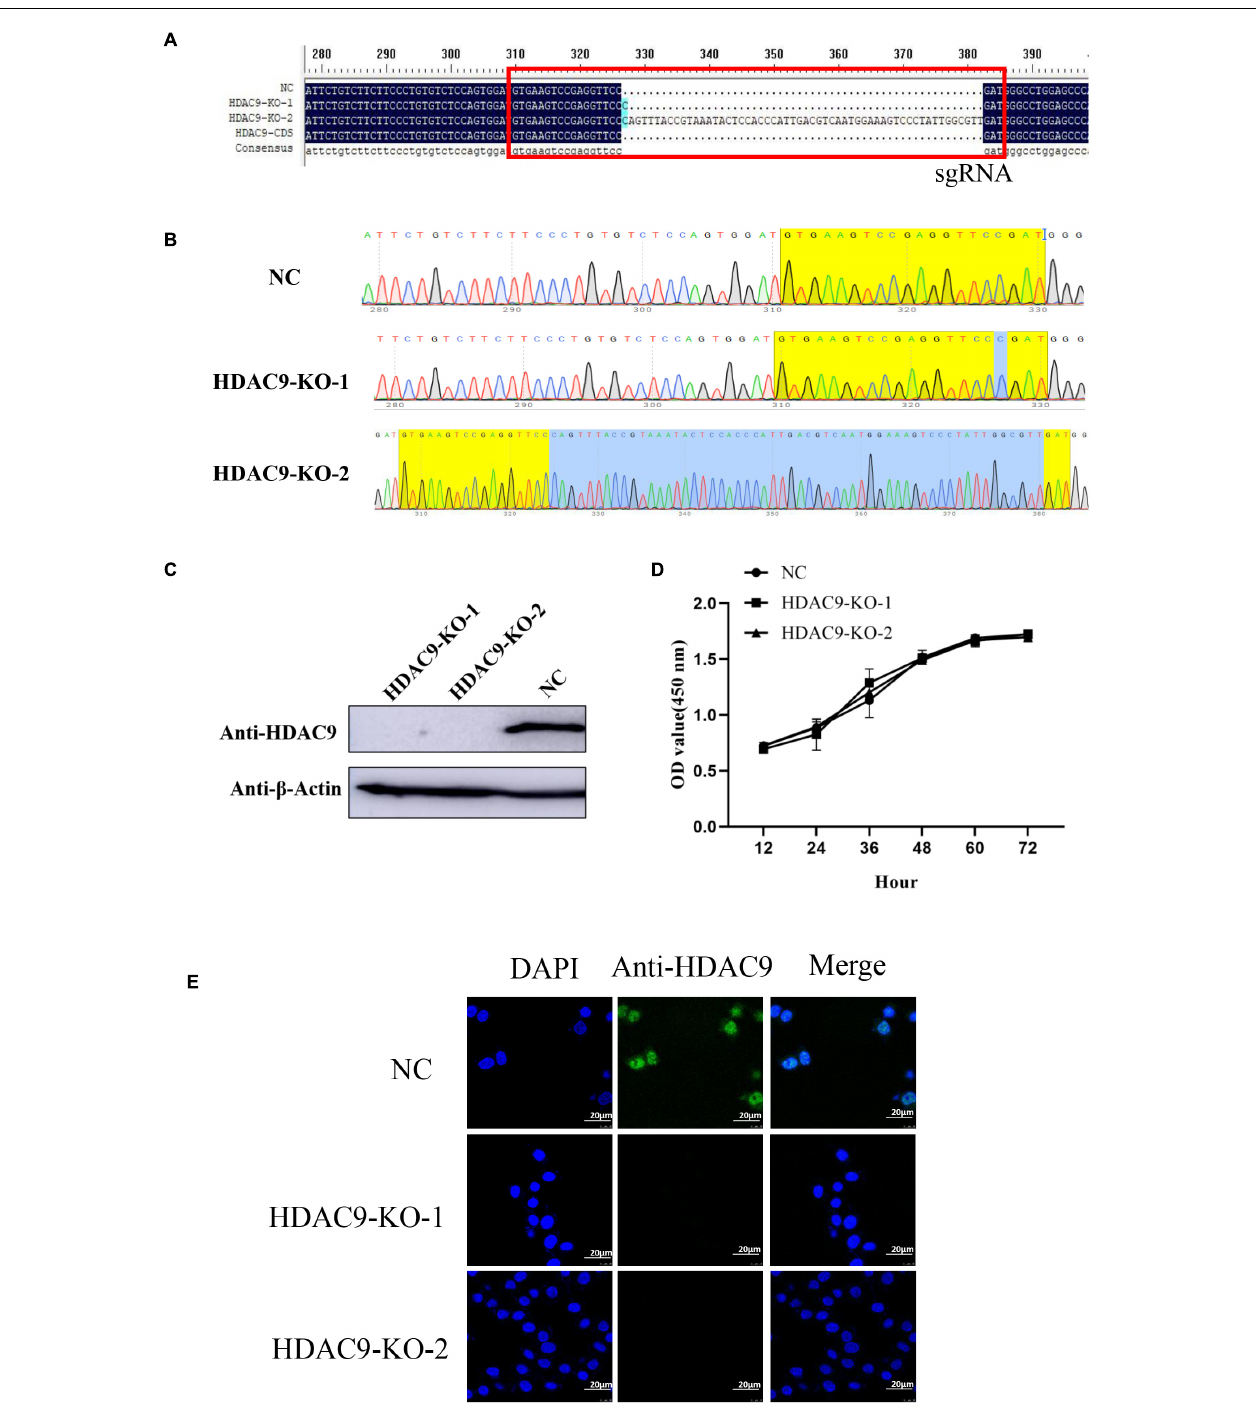
FIGURE 1 | Identification of the HDAC9 knockout BHK-21 cells. (A) Alignment of the NC (cells transfected with empty vector and selected by puromycin), HDAC9-KO-1, HDAC9-KO-2, and HDAC9 CDS sequences using DNAMAN software. The red box indicates the sgRNA sequence and the mutations in PAM motif. (B) Snapgene software was used to confirm the sequencing peaks of PCR products of NC, HDAC9-KO-1, and HDAC9-KO-2. (C) The expression of HDAC9 was detected by Western blotting with HDAC9 antibody, and β -Actin was used as a control to show the even loading of samples. (D) NC and HDAC9-KO cells (HDAC9-KO-1 and HDAC9-KO-2) were seeded in 96-well plates at 1 × 10 4 cells/well. CCK8 reagent was added to each well for 10 µ L and incubated for 1 h, and then the absorption at 450 nm was determined. (E) Immunofluorescence assay of NC and HDAC9-KO cells (HDAC9-KO-1 and HDAC9-KO-2); the signals of HDAC9 protein were observed under a confocal microscope. Green signals represent HDAC9 and nucleus was stained with DAPI. Statistical significance was analyzed by Student’s t -test: * p < 0.05, ** p < 0.01.